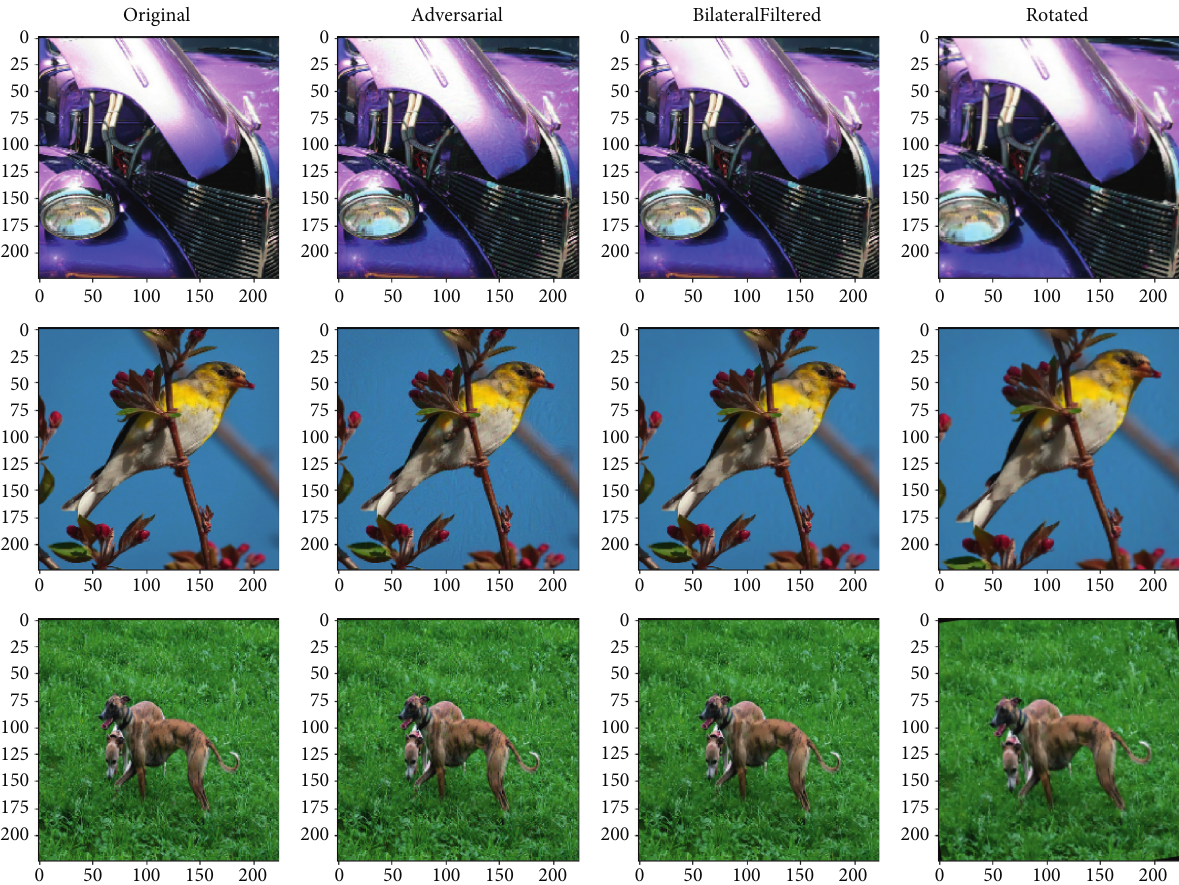
Figure 7: The images in each step of the proposed method (model � AlexNet, attack �